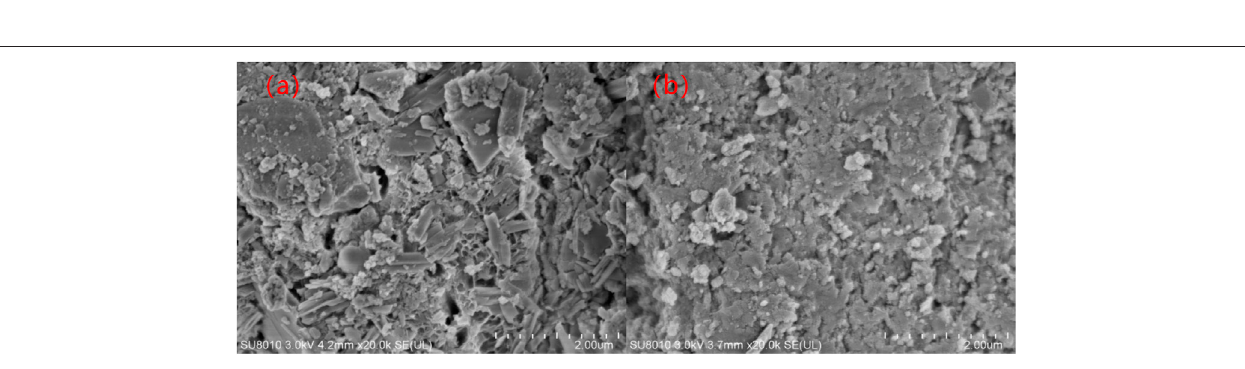
FIGURE 3 | SEM patterns of different hardened cement